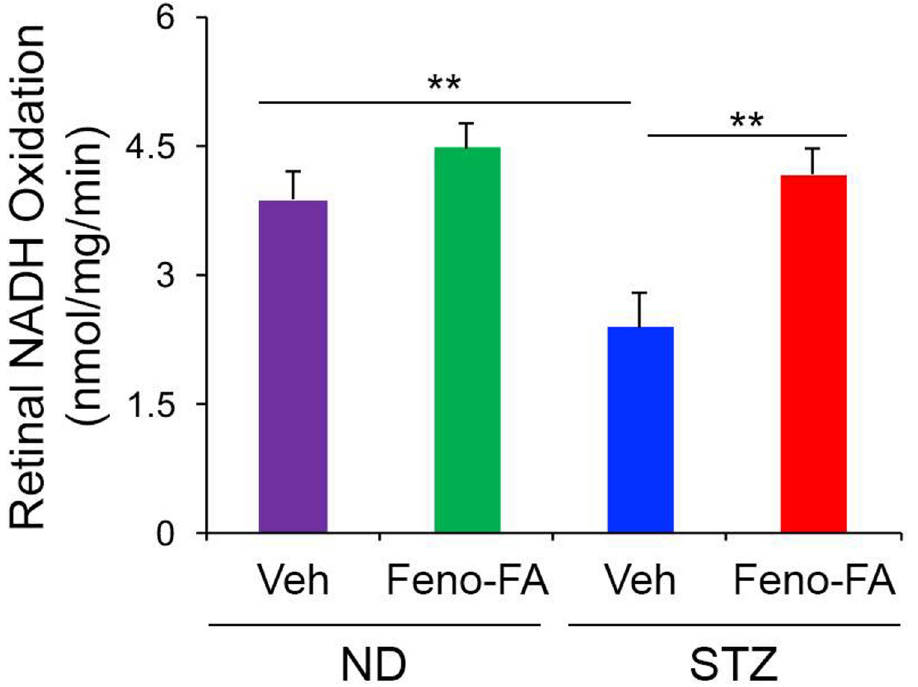
Fig 4. PPAR α restoration of retinal NADH-linked respiration in diabetic rats. Retinal NADH oxidation was decreased in Streptozotocin (STZ)-induced type 1 diabetic Sprague Dawley rats at 4 weeks diabetic relative to non- diabetic (ND) rats, and was restored by one week daily injection of fenofibric acid (Feno-FA) relative to Vehicle (Veh, DMSO)-injected diabetic rats. Feno-FA non-significantly increased retinal NADH oxidation in ND rats. (ND-Veh n = 8; ND-Feno-FA n = 7; STZ-Veh n = 4; STZ-Feno-FA n = 6 retinas). Data are expressed as mean ± SEM. � p � 0.05; �� p � 0.01, one-way ANOVA with Tukey’s post-hoc comparison.